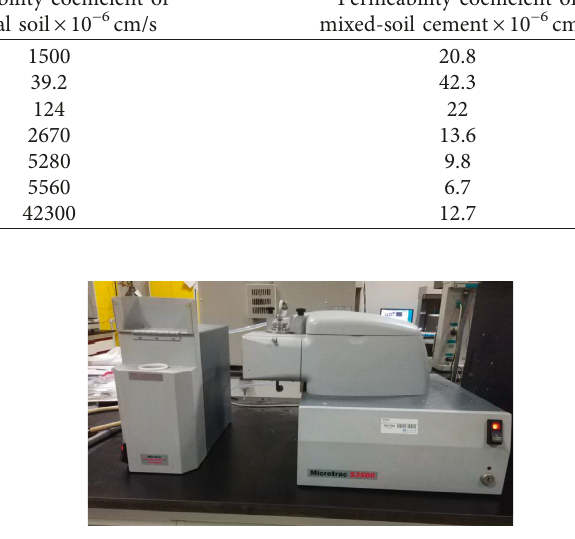
Figure 4: Microtrac S3500 laser particle size